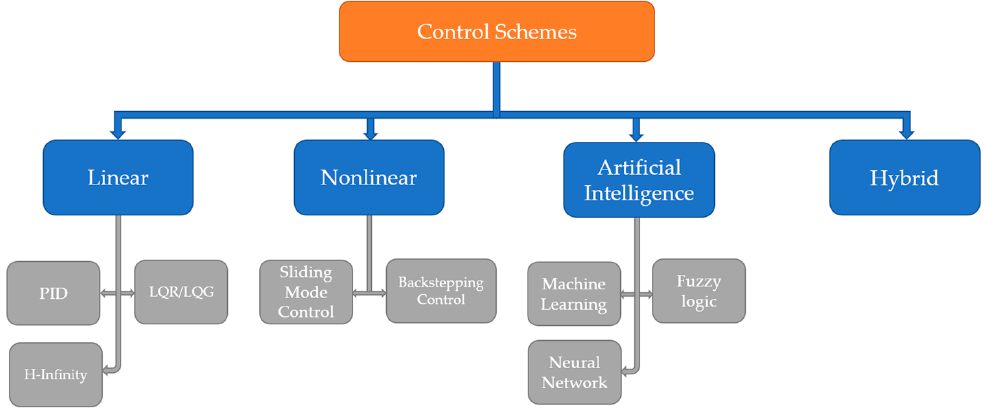
Figure 2. Control Systems Classifications.